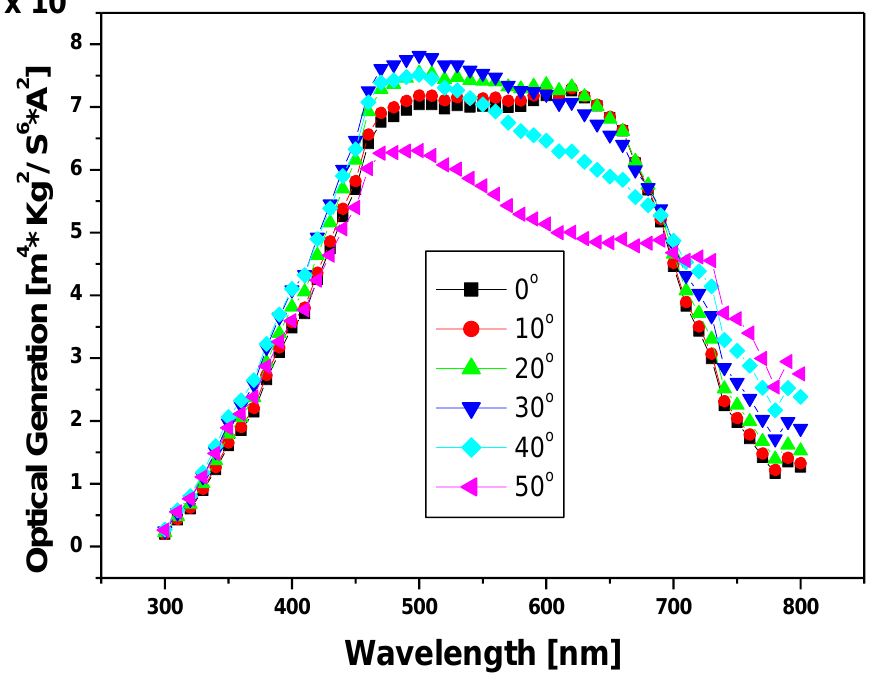
Figure 10. The optical generation of electron – hole pairs for the same structure as in Figure 9.